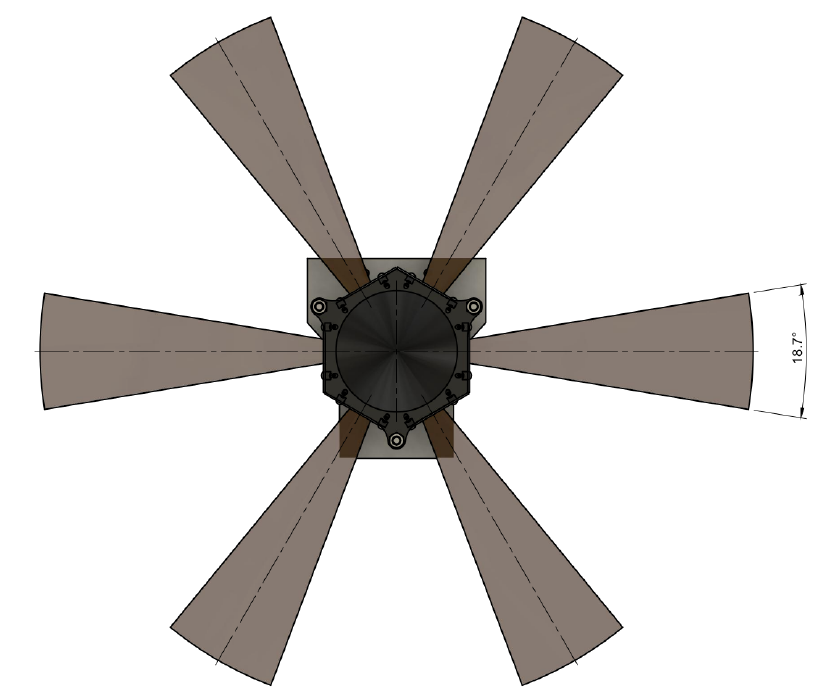
Figure 2. Reshaped field of view; plot of vertical situation.